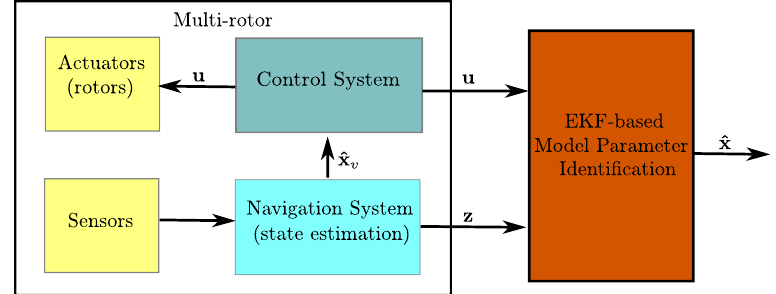
Figure 2. Block diagram of the proposed EKF-based model parameter identification